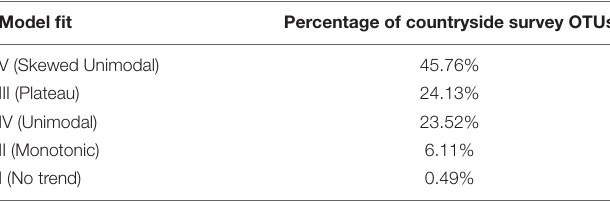
TABLE 2 | Percentage of 13,781 CS OTUs fitted to each HOF model. Model